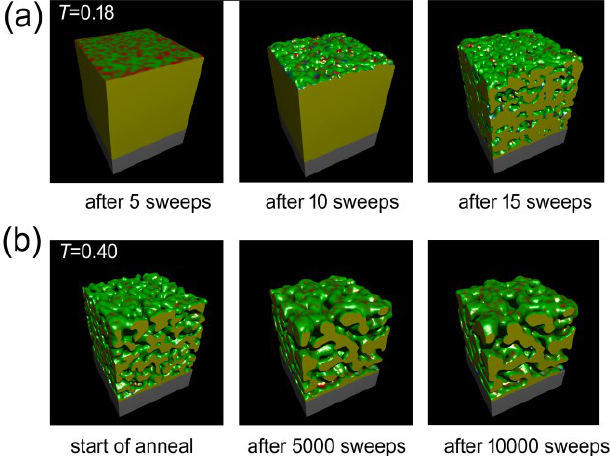
Figure 6. Results of Monte Carlo simulation of the evolution of sponge morphology with time for the case of a sponge prepared from precursor containing 65 at.% Al. ( a ) Change in morphology at T = 0.18 as de-alloying proceeds, ( b ) Change in morphology at T = 0.40 as sponge is